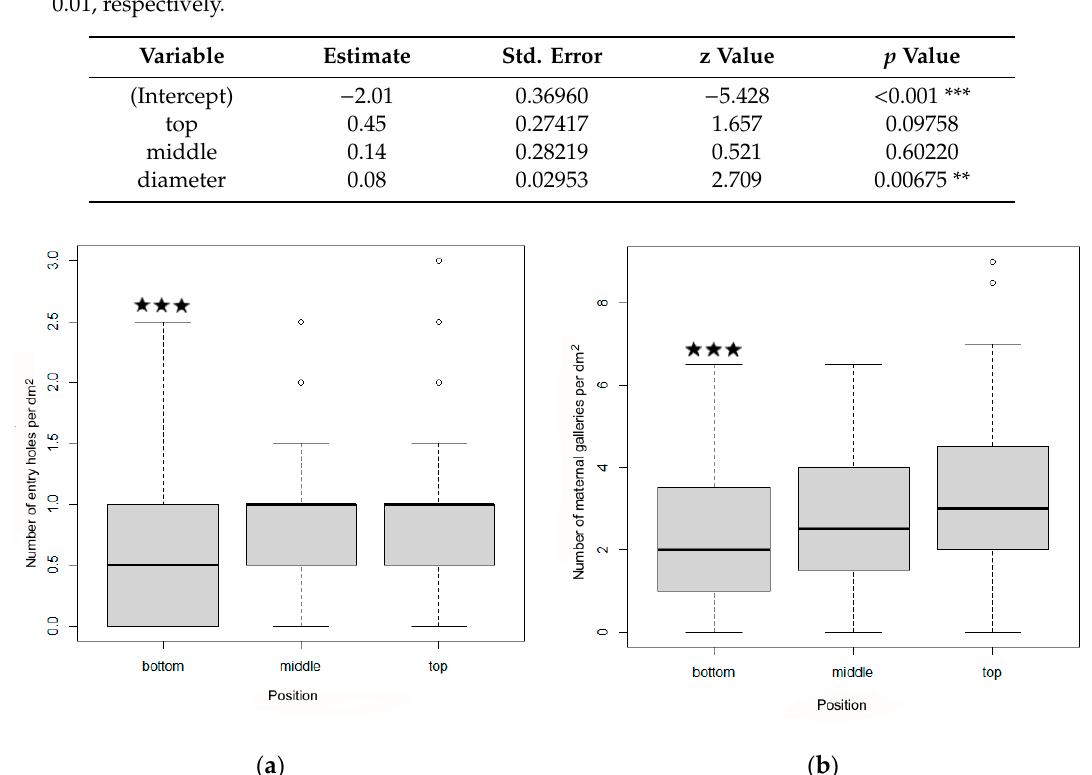
Figure 5. Number of entry holes ( a ) and maternal galleries ( b ) at top, middle, and bottom positions of the logs in experiment 1. The boxes indicate medians and interquartile range, the whiskers indicate minimum and maximum values, and circles indicate outliers. *** indicate significance at p < 0.001. Table 4. Results of a GLM model describing the relationship between the number of entry holes of Ips cembrae per dm 2 and the following variables in experiment 1: position on the log (top, middle, and bottom = included in Intercept); diameter. Corrected Akaike’s Information Criterion (AIC) = 210.09. Number of Fisher Scoring iterations was 5. ***, and * indicate significance at p < 0.001, and 0.05, respectively.